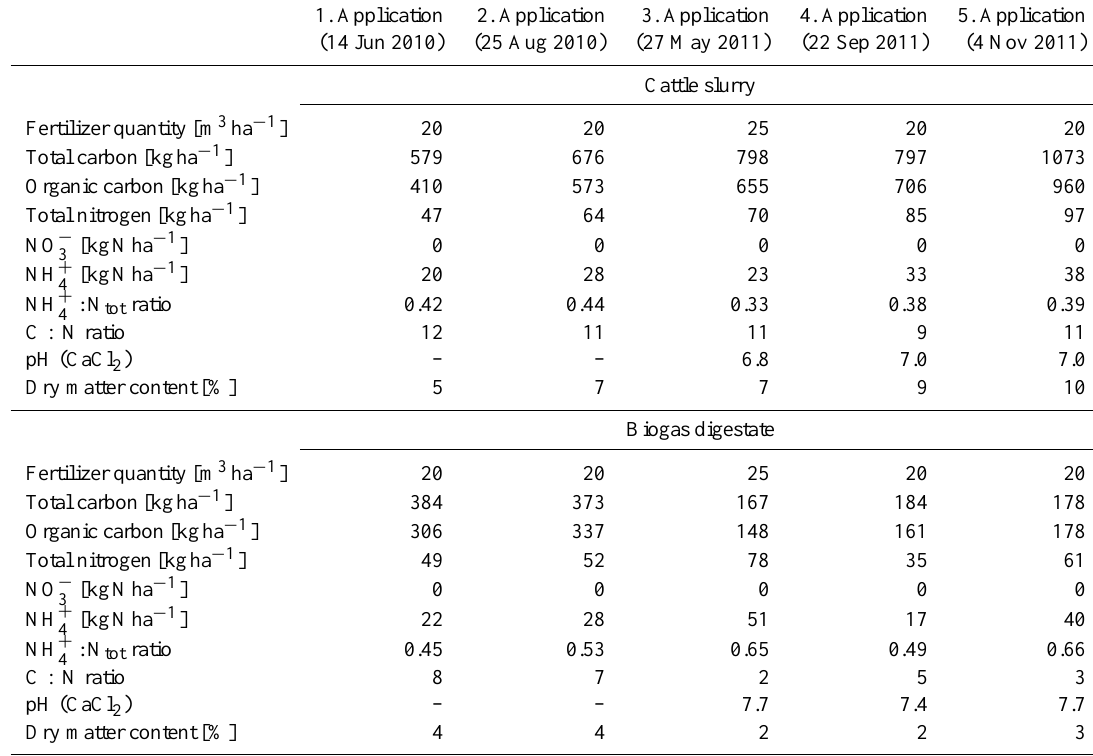
Table 3. Physical and chemical properties of the applied digestates and slurries. 1.